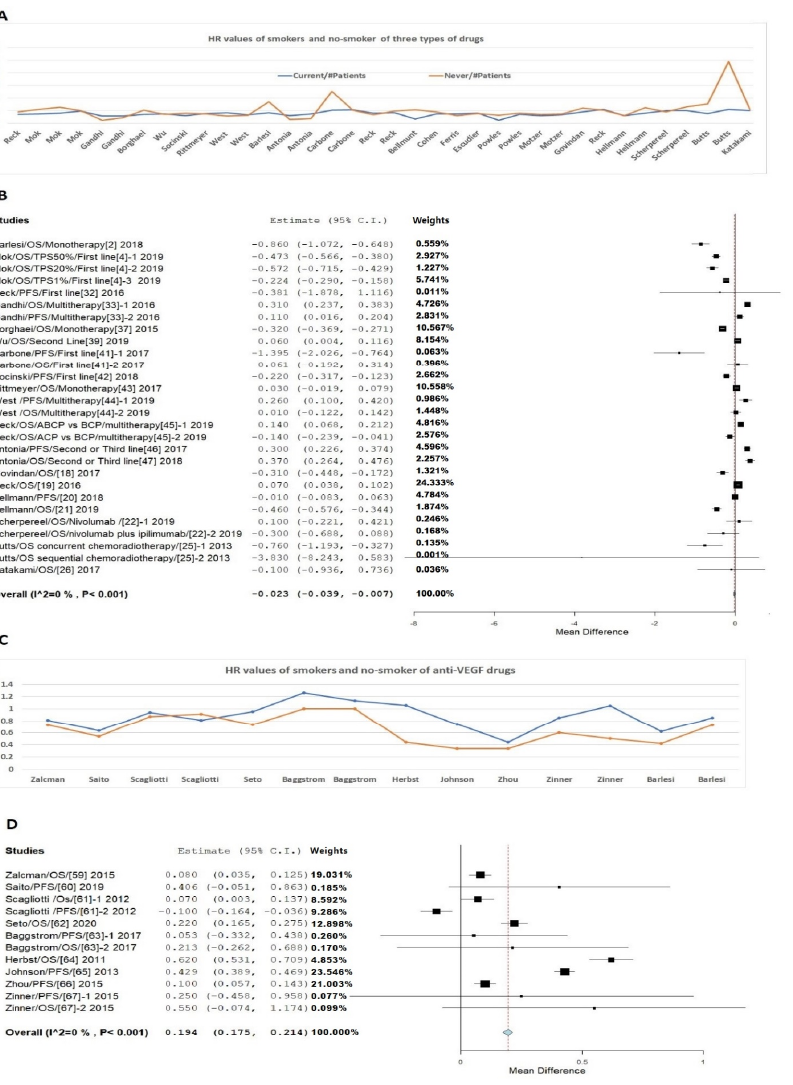
Figure 1. HR values of patients treated with different drugs. ( A ) HR data from three types of drugs (anti-PD-1/PD-L1, anti-CTLA-4 drug, and anti-MUC1 drug). ( B ) Meta-analysis of HR for these three types of drugs. ( C ) HR data from Bevacizumab on NSCLC between smokers and non-smokers. ( D ) Meta-analysis of HR Bevacizumab on NSCLC between smokers and